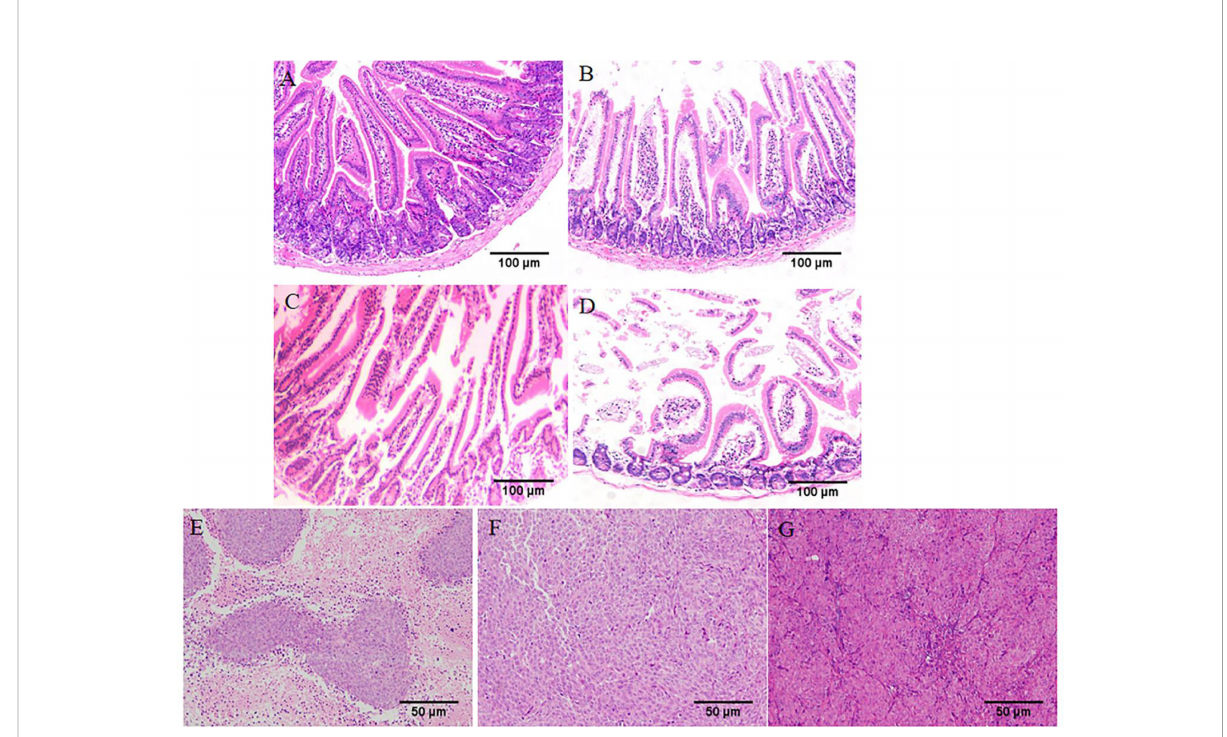
FIGURE 4 Upregulation of HIF1 a can exacerbate intestinal mucosal destruction and increase tumor malignancy. Structural changes of intestinal mucosa of tumor-bearing mice were observed under light microscope (HE staining, ×100). (A) control group, (B) HIF1 a (-/-) group, (C) HIF1 a (+/+) group, (D) HIF1 a OE group. The tumor structure was observed under a light microscope (HE staining, ×200). (E) HIF1 a (-/-) group, (F) HIF1 a (+/+) group, (G) HIF1 a OE